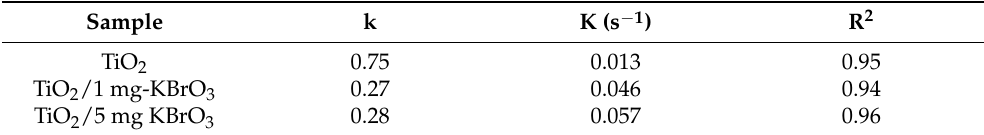
Figure 7. Semi-logarithmic relationship of the dye concentration change vs. the irradiation time for TiO 2 , TiO 2 /1 mg-KBrO 3 , and TiO 2 /5 mg-KBrO 3 samples. Table 1. First-order reaction rate constants (k) and the degradation equilibrium constant (K) for the 20 mg/L of PR for TiO 2 , TiO 2 /1 mg-KBrO 3 , and TiO 2 /5 mg-KBrO 3 samples at 303 K.